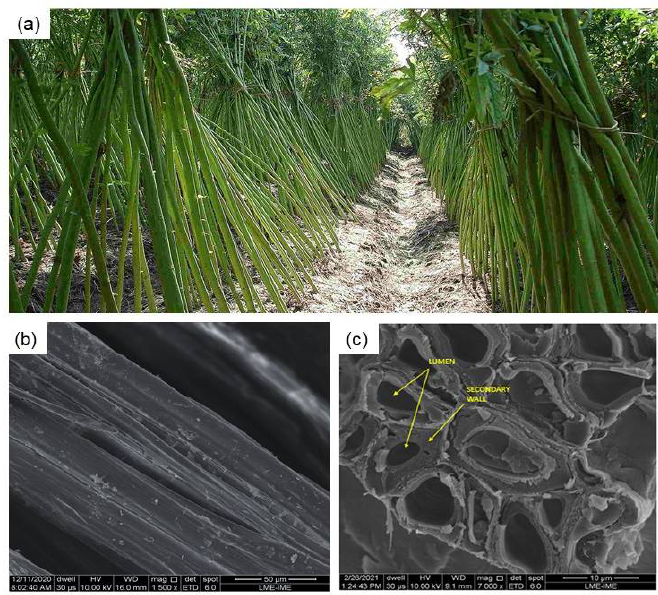
Figure 1. ( a ) Kenaf plants; ( b ) SEM image of a longitudinal section of the kenaf fiber; ( c ) SEM image of a cross-section of the kenaf fiber indicating the lumen and secondary walls of the fiber.